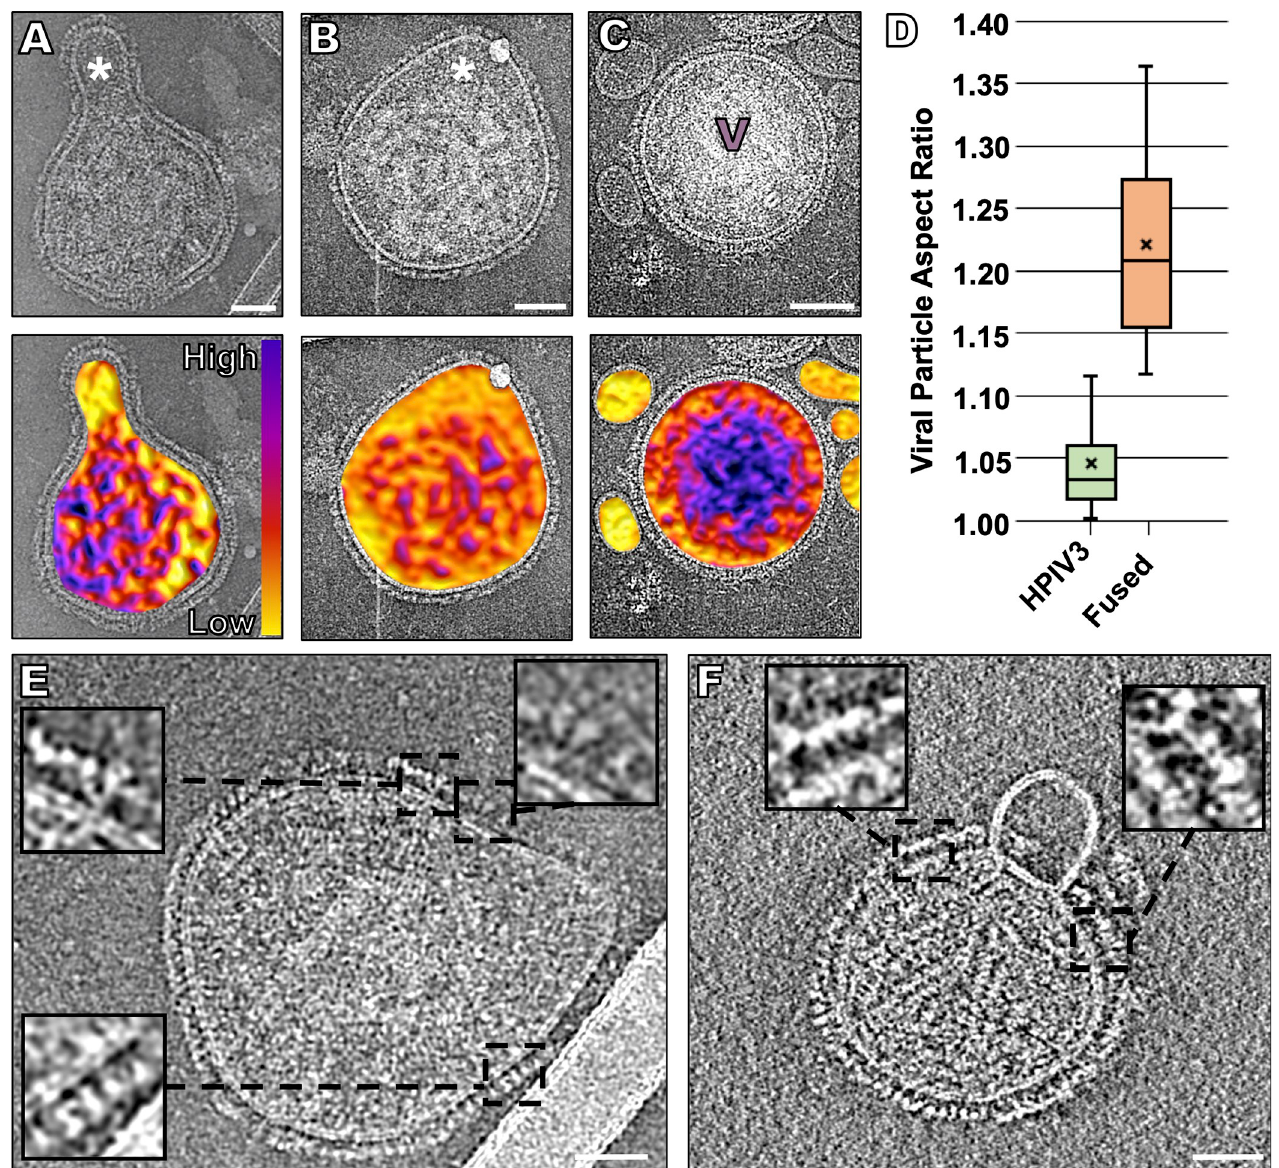
Fig 5. Fusion of HPIV3 with a target erythrocyte fragment membrane. ( A, B ) Contrast-inverted viruses that underwent fusion with target erythrocyte fragment membranes (top) with density color representation overlaid below. The purple color represents the dense viral ribonucleoprotein, and the yellow color represents the erythrocyte content. ( C ) Negative control where grids were kept at 4˚C, prior to vitrification to prevent fusion of target erythrocyte membranes with the viruses. ( D ) Particle aspect ratio of viruses in the presence of zanamivir (also incubated at 4˚C, as in C ), compared to fused particles (n = 23). ( E ) Fusion with a small target erythrocyte fragment membrane reveals a lack of prefusion F density near the sites of fusion (inserts). ( F ) A possible instance of hemifusion where the target erythrocyte fragment membrane surface shows no evidence of surface glycoproteins, and the viral surface shows a lack of prefusion F density near the sites of fusion (inserts). Scale bars: ( A-C ) and ( E, F ) 50 nm. discerned by density differences that correspond to regions of the virus that have lost their sphericity ( Fig 5D ). To highlight those density differences, we represented content density using a color scale ( Fig 5A and 5B lower panels ). In contrast, when grids were kept at 4˚C to prevent erythrocyte-virus fusion, viral particles retain their sphericity, and no density fluctua- tions are observed within them ( Fig 5C and 5D ). A physiological host target cell would clearly